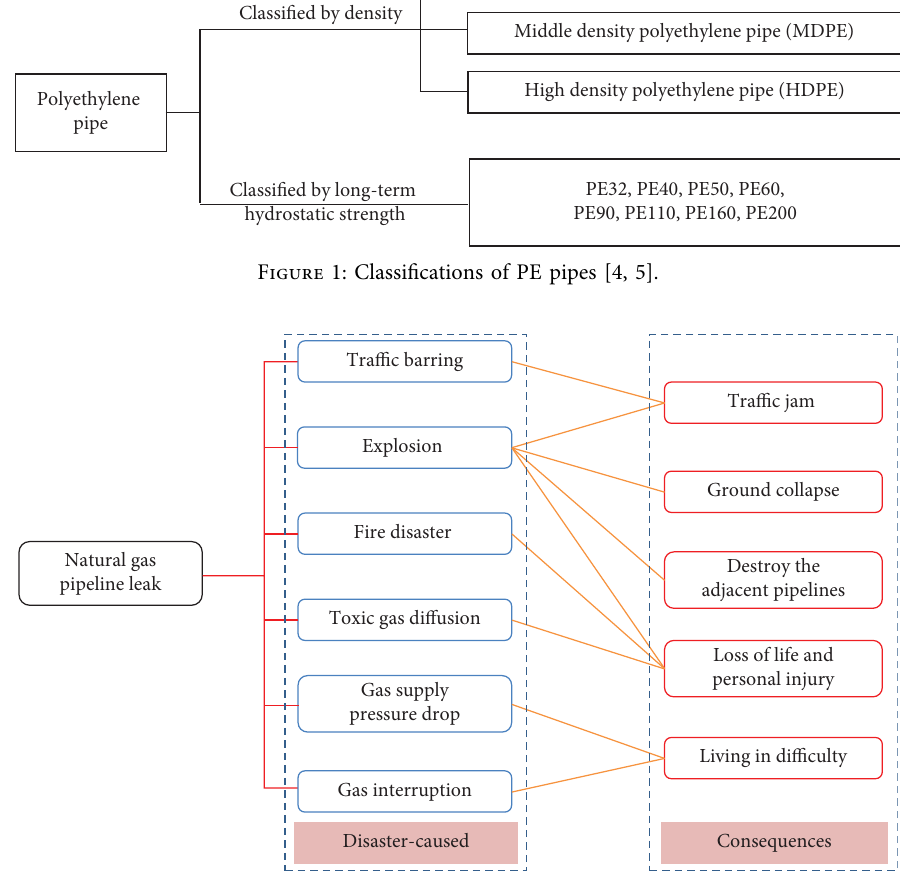
Figure 2: Topology diagram of disaster evolution for natural gas pipeline leaks